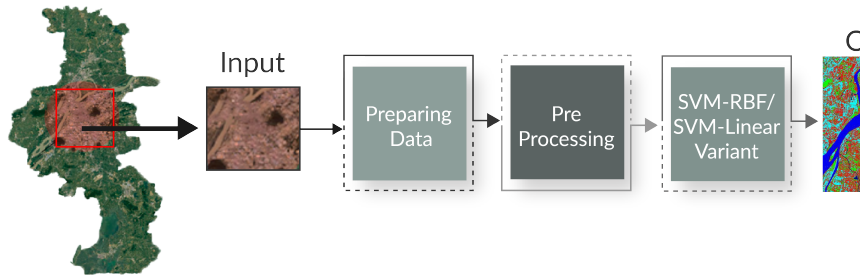
Figure 1. The proposed framework of the remote sensing image